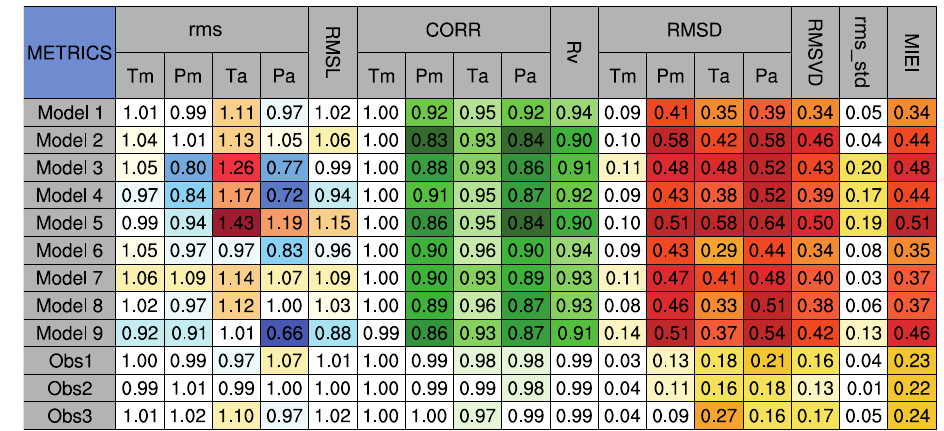
Table 1. Multiple statistics of CMIP5 models in simulating surface air temperature and precipitation in terms of climatological mean state and interannual variability. Tm (Pm) is the climatological mean surface air temperature (precipitation) in summer (June–July–August). Ta (Pa) is the temporal standard deviation of summer surface air temperature (precipitation). CMIP5 simulations and three individual groups of observational datasets are compared with the ensemble mean of three groups of SAT and precipitation data observed during the period from 1961 to 2000. The rms is the ratio of modeled to observed root mean square values of the spatial pattern for each variable. CORR (RMSD) is the uncentered spatial correlation coefficient (root mean square deviation) between model and observational fields. RMSL, Rv, and RMSVD measure the statistics of two vector fields, which can represent the overall statistics of all fields (Eqs. 3, 13, 16). RMSL was shown as the ratio of model simulated RMSL to the observed RMSL. The rms_std is the standard deviation of four rms values, which describe the dispersion of rms values of Tm, Pm, Ta, and Pa (Eq. 23). MIEI is the multivariable integrated evaluation index (Eq. 24). Model performance is indicated by the color scale; lighter colors denote better model